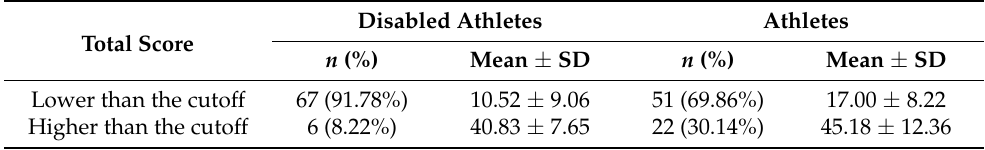
Table 2. IES.R total score (IES-R TS) questionnaires (mean ± SD).